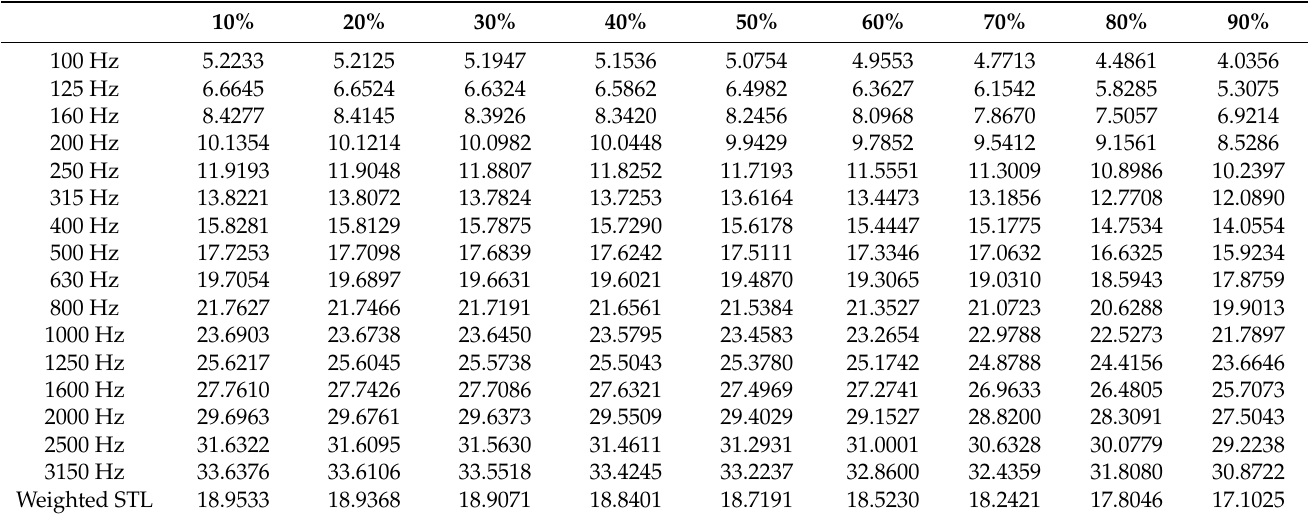
Table 5. The summarized STL data with the various hollow ratio of the HGM.